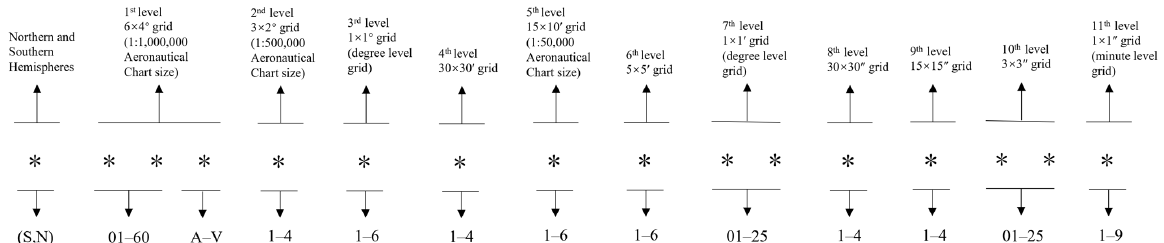
Figure 4. Four different types of fill curves: ( a ) 2 × 3 profiling; ( b ) 2 × 2 profiling; ( c ) 3 × 2 profiling; ( d ) 5 × 5 profiling.